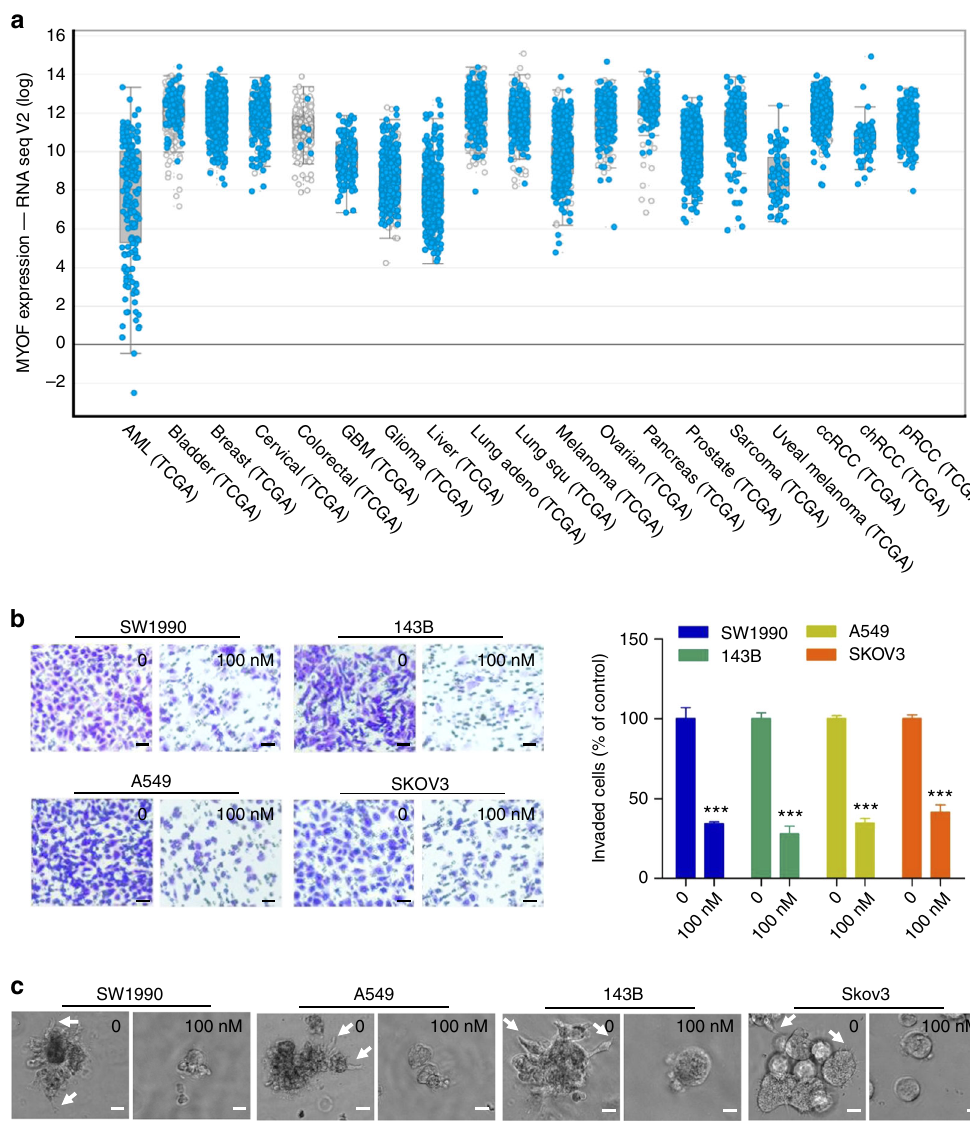
Fig. 7 WJ460 attenuates the metastatic ability of cell lines derived from other tumors. a The expression of MYOF gene was detected in various cancers using cBioportal online Web resource (cBioportal for Cancer Genomics). b Transwell invasion assay. Various cancer cell lines were re-suspended in serum- free medium containing increasing concentrations of WJ460 and seeded into transwell inserts precoated with 10% matrigel. After 12 h, invaded cells were stained with 0.1% crystal violet. Images were acquired using an inverted microscope (Olympus) ( n = 3). Scale bars, 50 μ m. Data shown are mean ± s.d. *** p < 0.001. c 3D on-top culture assay. Cells were plated above a layer of Matrigel and covered with growth medium containing 10% Matrigel and the indicated concentration of WJ460 ( n = 3). Arrows, stellate invasive structure. Scale bars, 20 μ m. In b , c , n indicates the number of